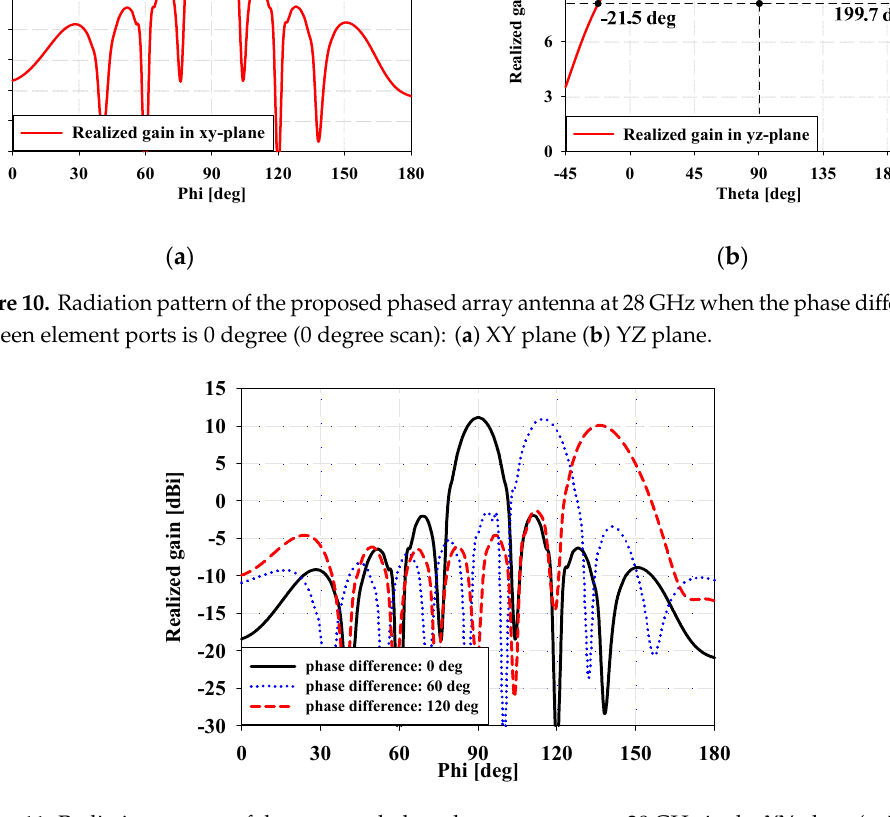
Figure 11. Radiation pattern of the proposed phased array antenna at 28 GHz in the XY plane (azimuth) when the phase difference between element ports is varied from 0 degree to 120 degree with a step of 60 degree.